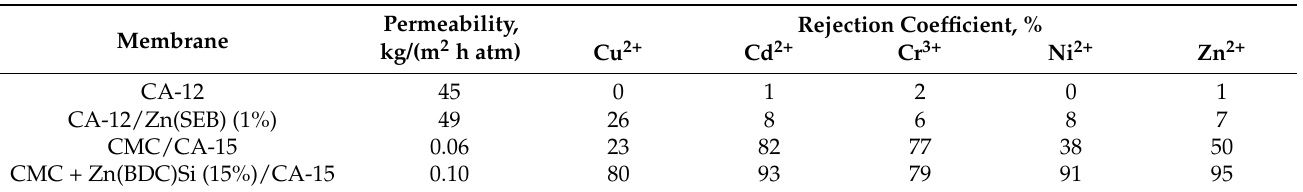
Table 3. Transport properties of membranes in nanofiltration of wastewater from galvanic production containing heavy metal ions (Cu 2+ , Cd 2+ , Cr 3+ , Ni 2+ , Zn 2+ ). Membrane